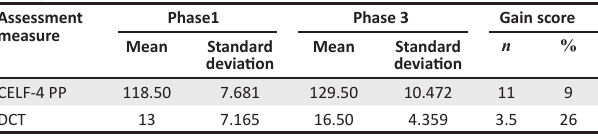
TABLE 1: Experimental group: Statistical analysis of assessment scores (Phases 1 and 3). Assessment measure